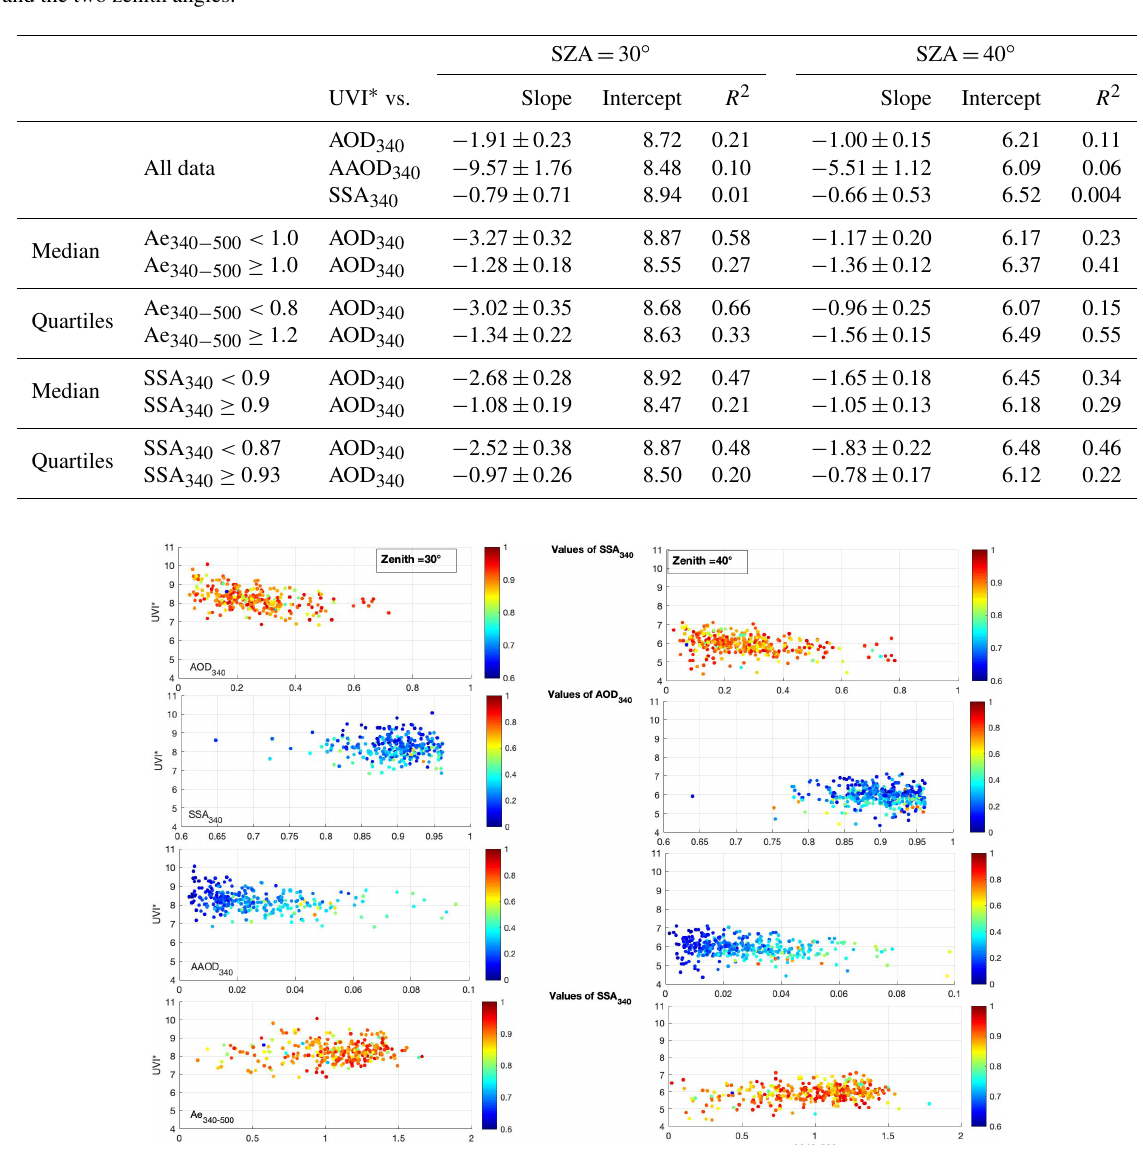
Figure 5. Scatterplot of UVI ∗ vs. AOD 340 (top), SSA 340 (second raw), AAOD 340 (third raw), and Ae 340 − 500 (bottom) for solar zenith angles of 30 ◦ (left) and of 40 ◦ (right). The colors represent the values of SSA 340 (first and fourth rows) and AOD 340 (second and third